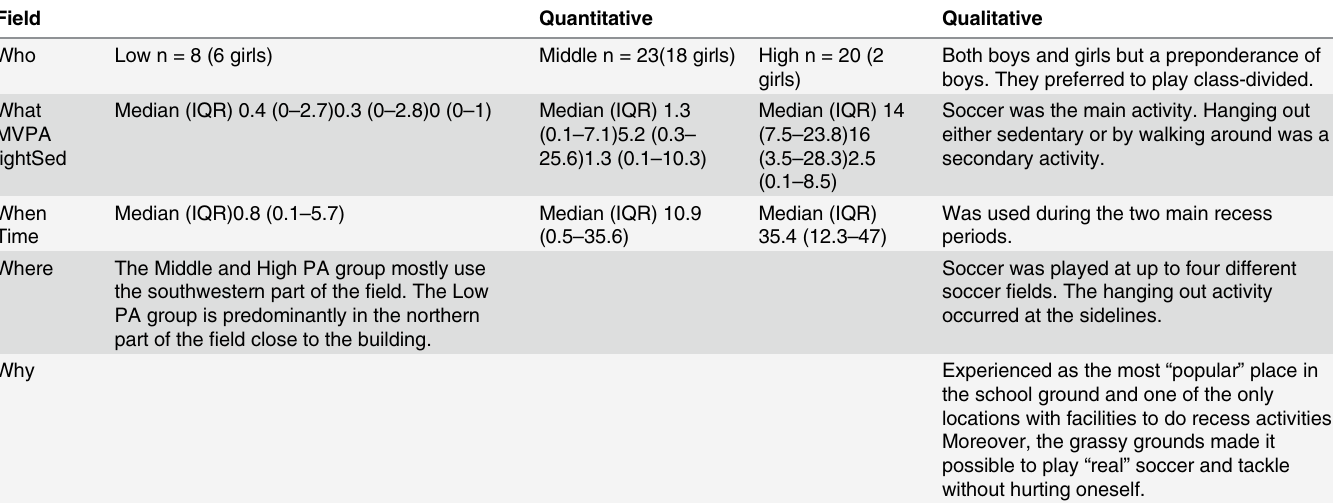
Table 3. Characteristics of time spent, activity level and behavior on the field during recess.